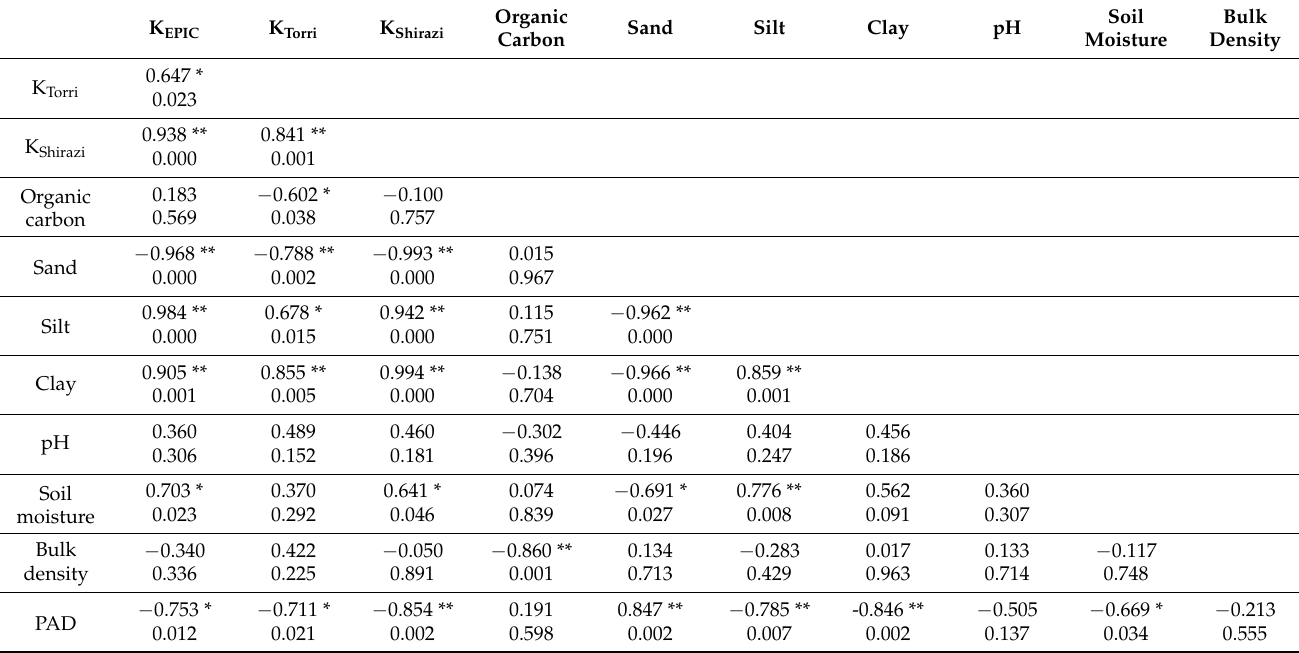
Table 4. Correlations between K value and soil physical and chemical